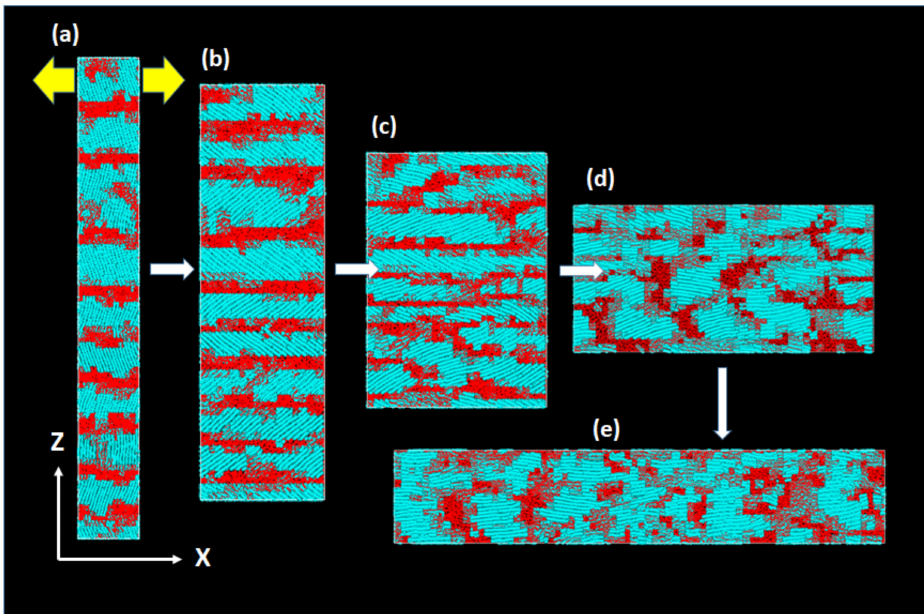
Figure 10. Uniaxial deformation along the X -axis, with the true rate 0.05/ns, for the type-T (Figure 8b) in the well-developed stacked lamellae system of 150,000 united atoms. The times (and the Hencky- strain) for the deformation are ( a ) 1 ns (0.05), ( b ) 10 ns (0.5), ( c ) 20 ns (1.0), ( d ) 30 ns (1.5), and ( e ) 40 ns (2.0). The blue and red regions correspond to the crystalline and amorphous regions,